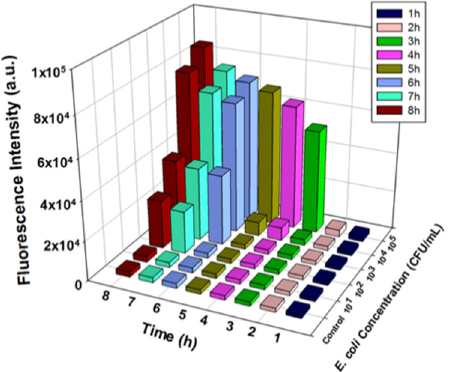
Figure 4. Fluorescence intensity measured from T7 lacZ phages infecting E. coli in LB at varying concentrations (0, 10, 10 2 , 10 3 , 10 4 , and 10 5 CFU/mL) after incubating for 8 h at 1 h intervals at 37 °C. The control group indicates the absence of bacteria in the reaction mixture. Data represent the mean of a minimum of three independent replicates.